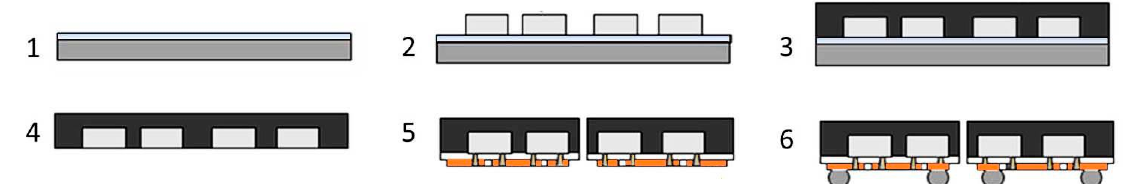
Figure 1. The process flow of mold-first FOWLP; (1) thermal release tape laminated on top of the temporary carrier, (2) face-down die-attach of the known-good-dies, (3) overmolding, (4) carrier removal, (5) RDL fabrication and (6) balling & dicing.